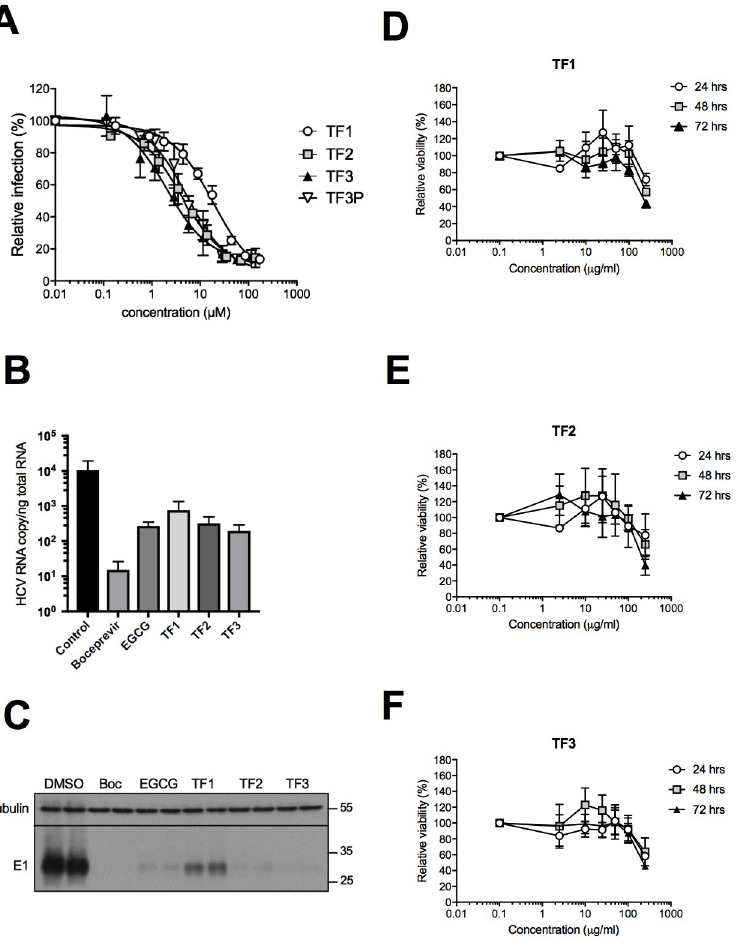
replaced with medium containing theaflavins. Cells were fixed at 30 h post-infection and subjected to immunofluorescence to quantify number of infected cells. Results are expressed relative to DMSO control without